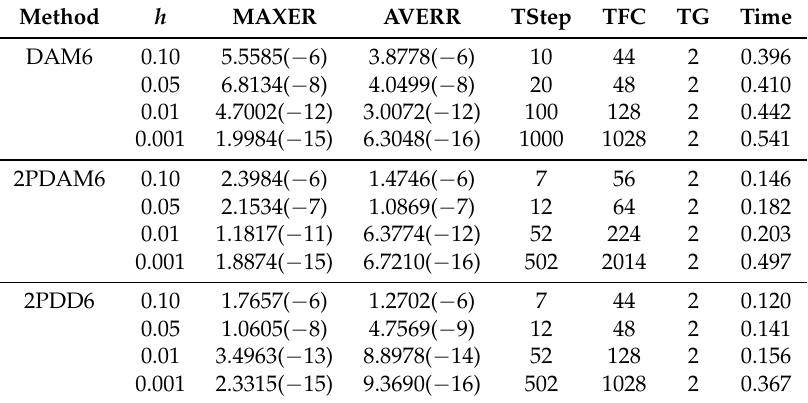
Table 2. Results for solving Test Problem 2.